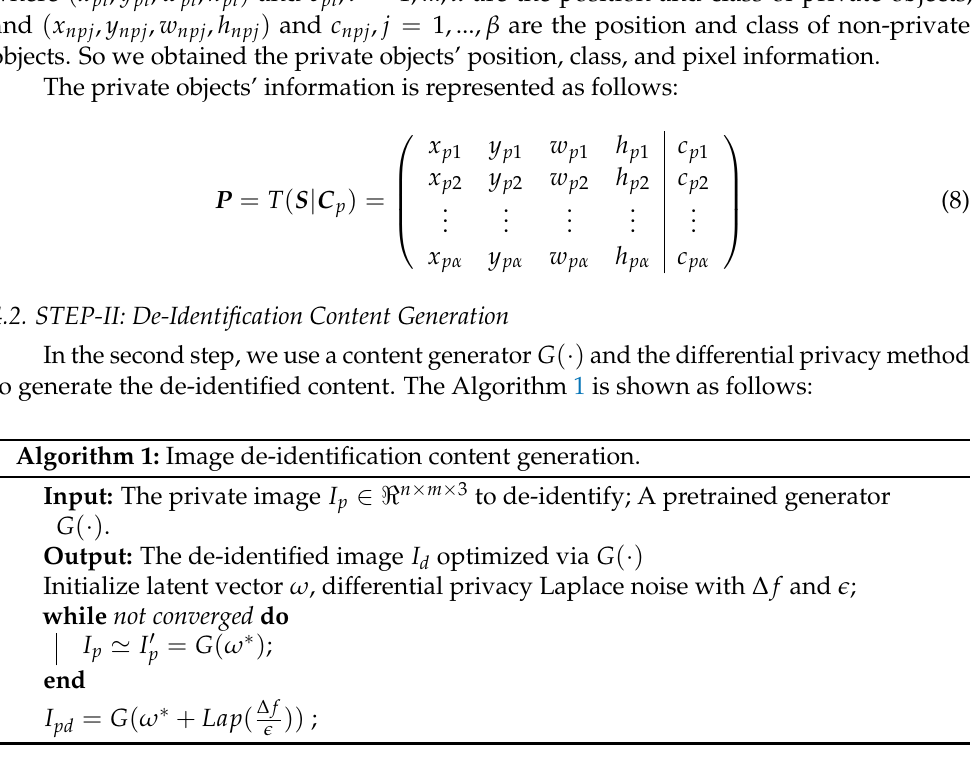
Figure 7 is the diagram of de-identification content generation part in our